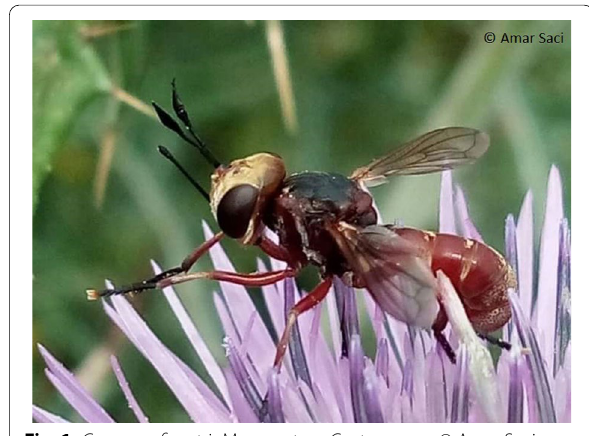
Fig. 1 Conops rufiventris Macquart on Centaurea sp. © Amar Saci